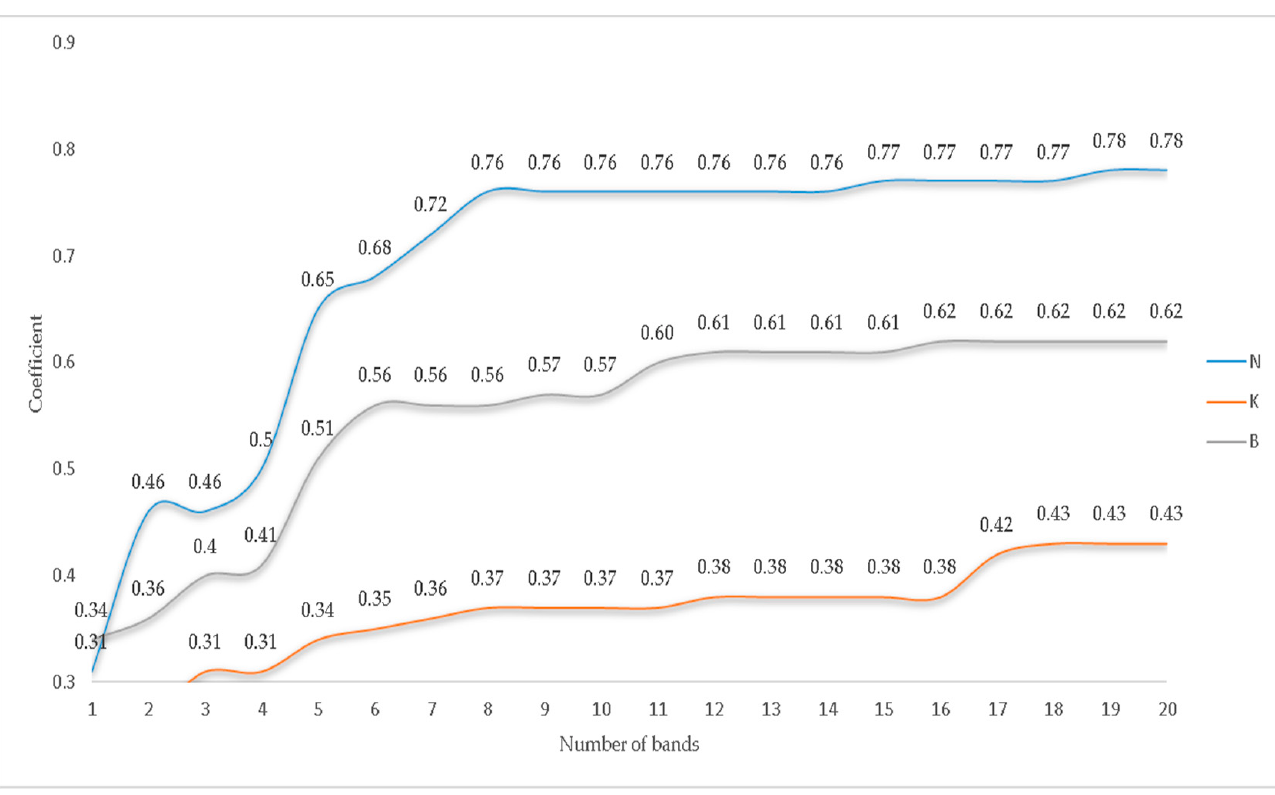
Figure 3. Coefficient R 2 obtained by the models as a function of the number of bands used for N, K and B. Table 4. Results of PLS-R using the selected bands for N and